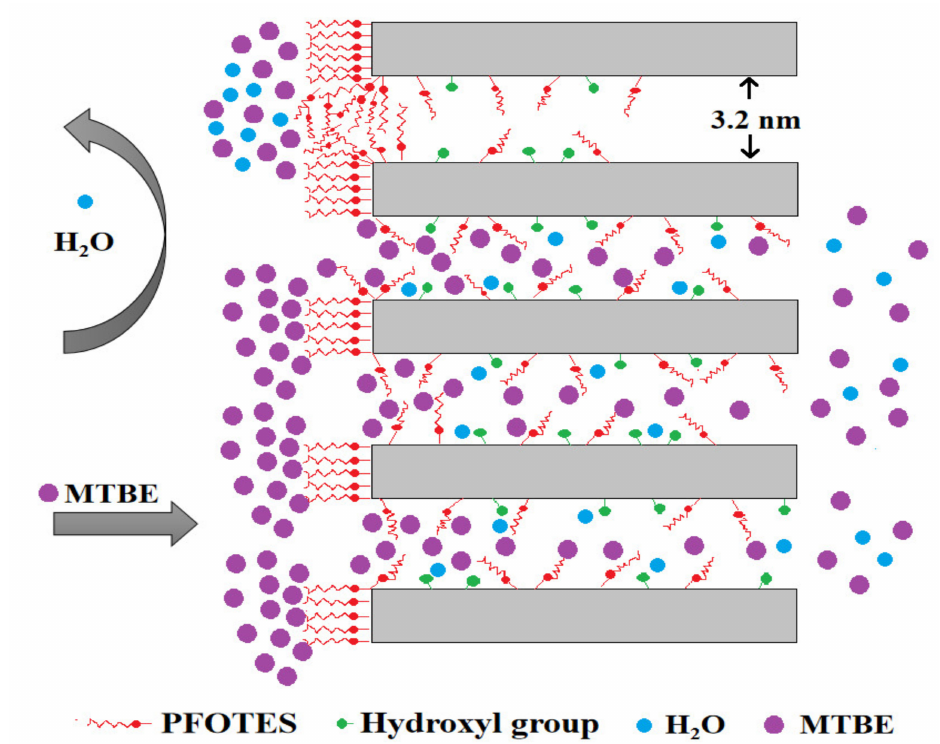
Figure 10. The proposed mechanism for the pervaporation separation of MTBE / water mixture by silylated silica